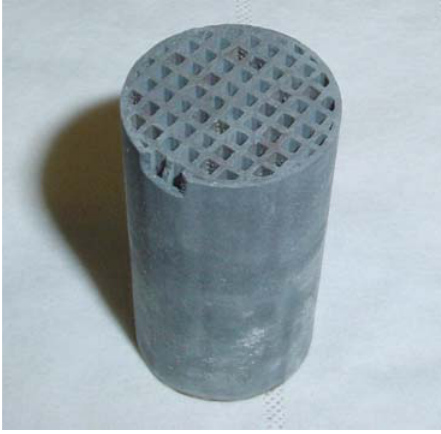
Figure 1. Siliconized silicon carbide (SiSiC) honeycomb structure used for